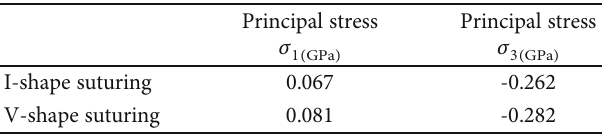
Figure 5: Distribution of principal stress near the pinhole of bionic skin, I-shape (a) and V-shape (b) suturing. Units: Table 1: The average stress index (ASI) of bionic skin in an area of 19 × 19 mm 2 .